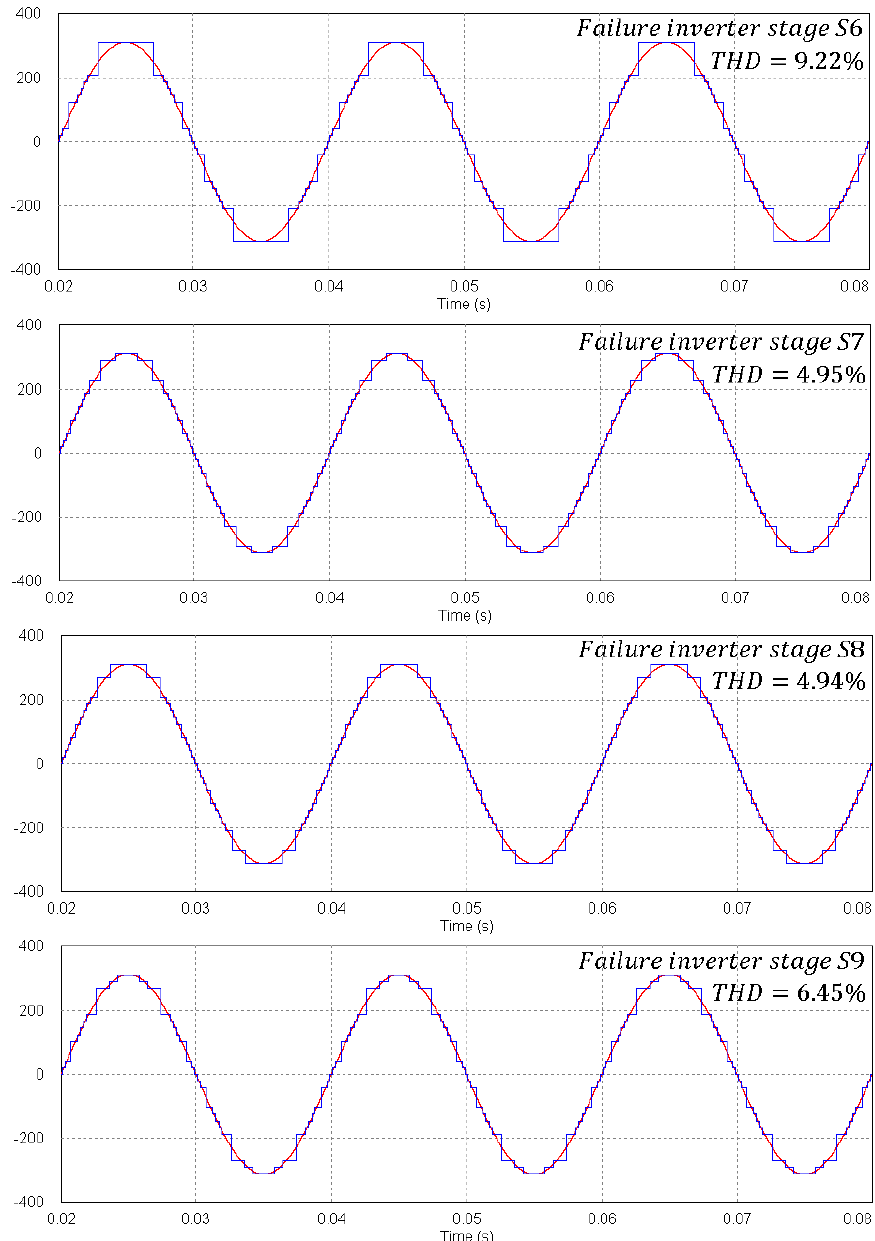
Figure 15. Simulated results for possible failures in one of the inverter